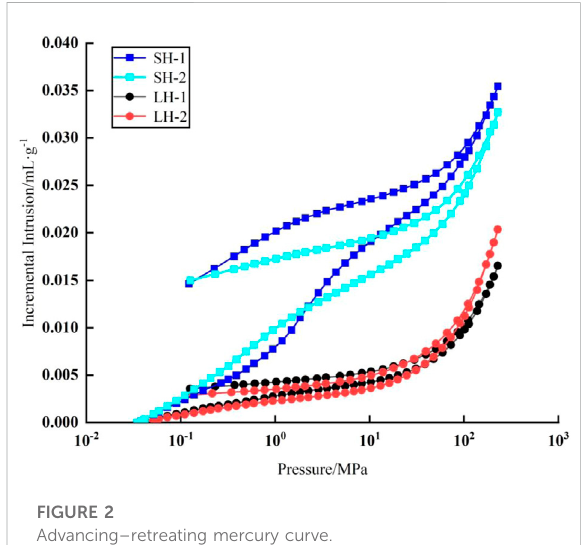
FIGURE 2 Advancing – retreating mercury